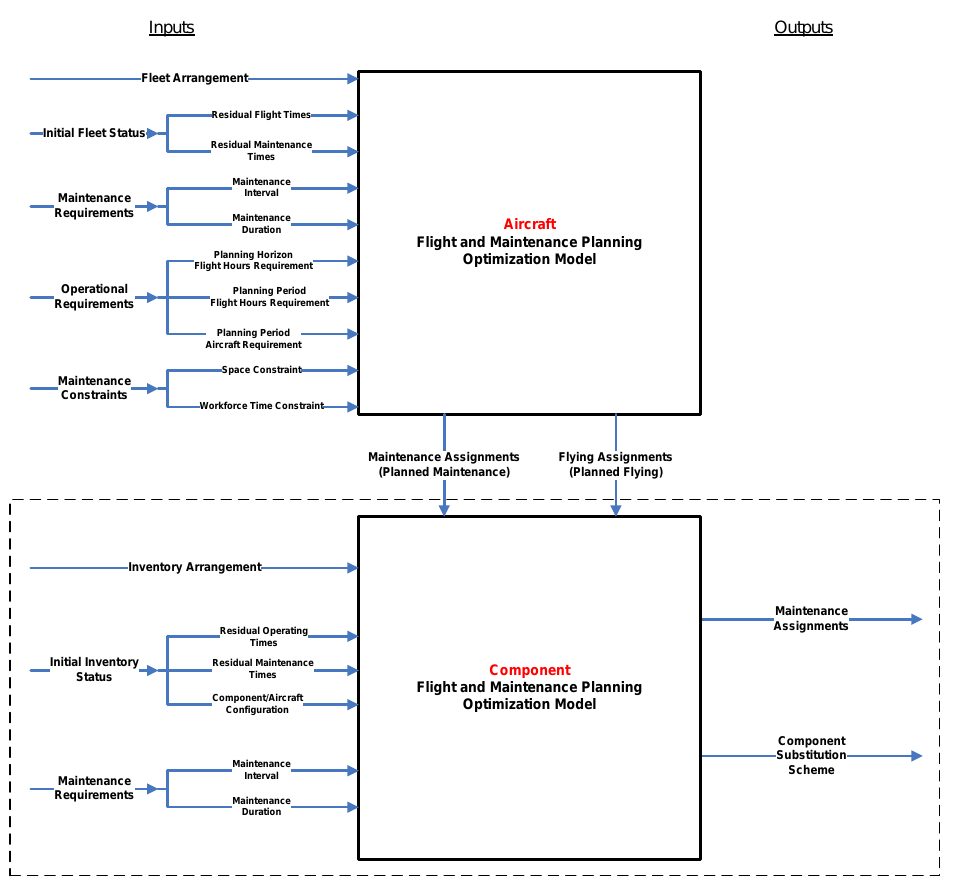
Figure 3. Representation of the component flight and maintenance planning optimization framework, showing the relationship with the aircraft FMP optimization model and the required in- and outputs. The dotted box denotes the area of focus of this